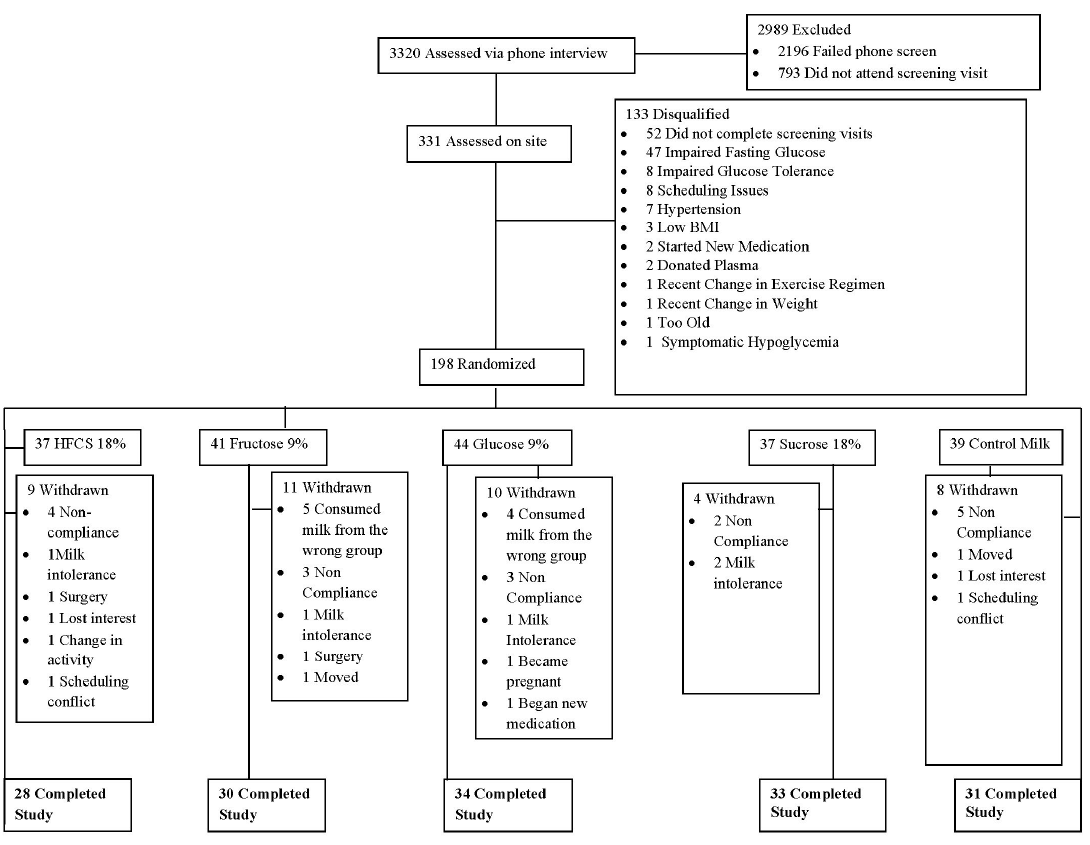
Figure 1. Participant flow through the various phases of the study.